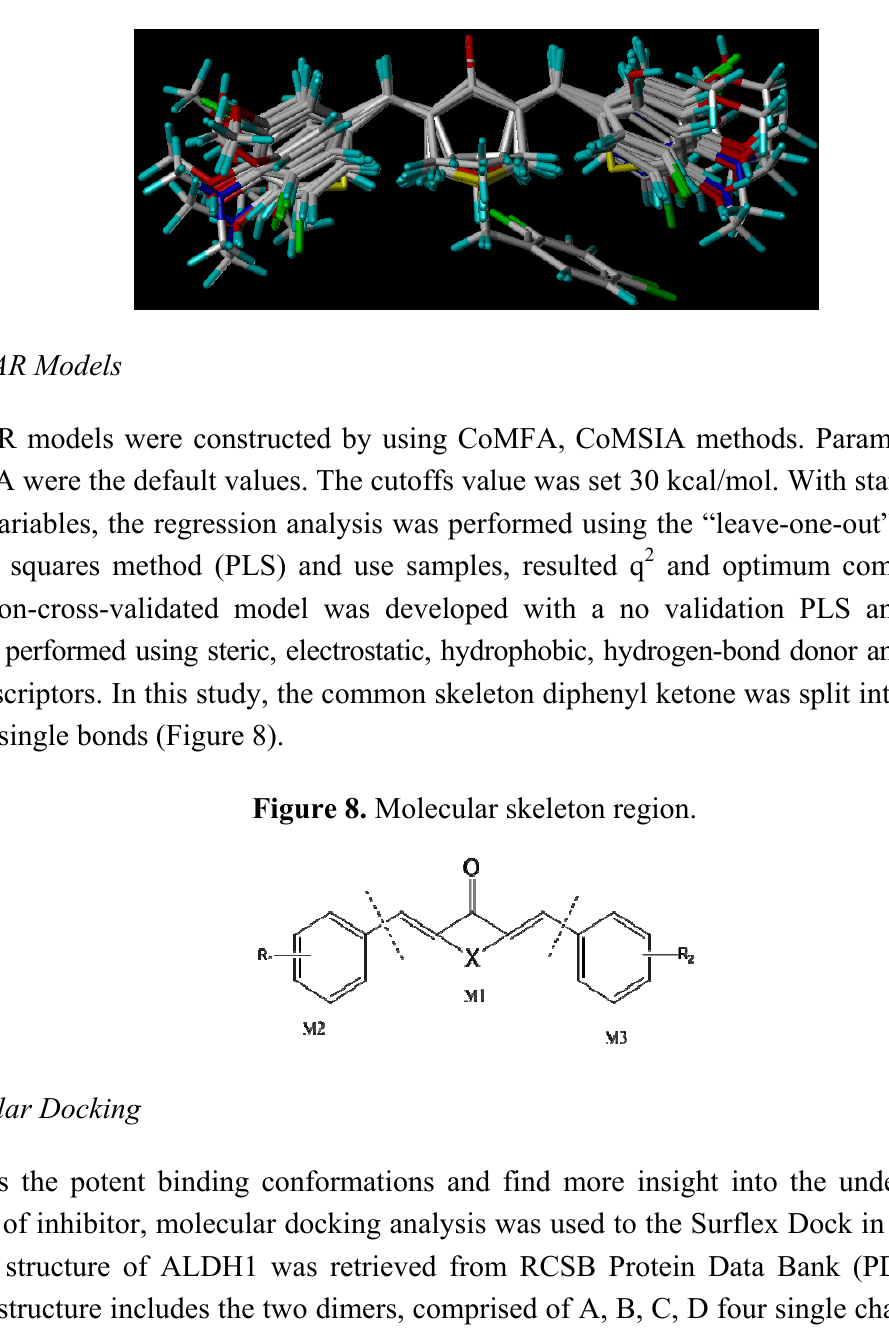
Figure 7. Molecular alignment of the compounds in the training set.